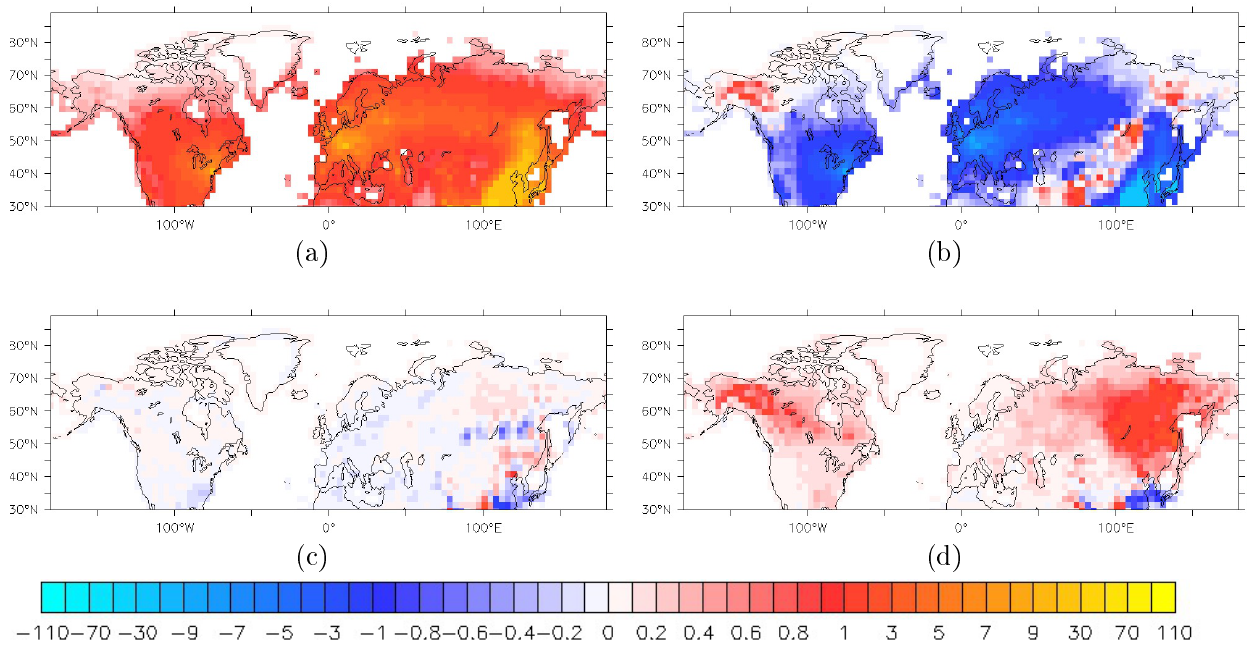
Fig. 5. Spring (Spring (April–May–June) BC continental deposition (mgm − 2 month − 1 ); (a) present-day deposition (S1, to- tal = 222Ggmonth − 1 ); (b) difference in deposition between RCP8.5 scenario for 2050 and present-day simulation (S2–S1,